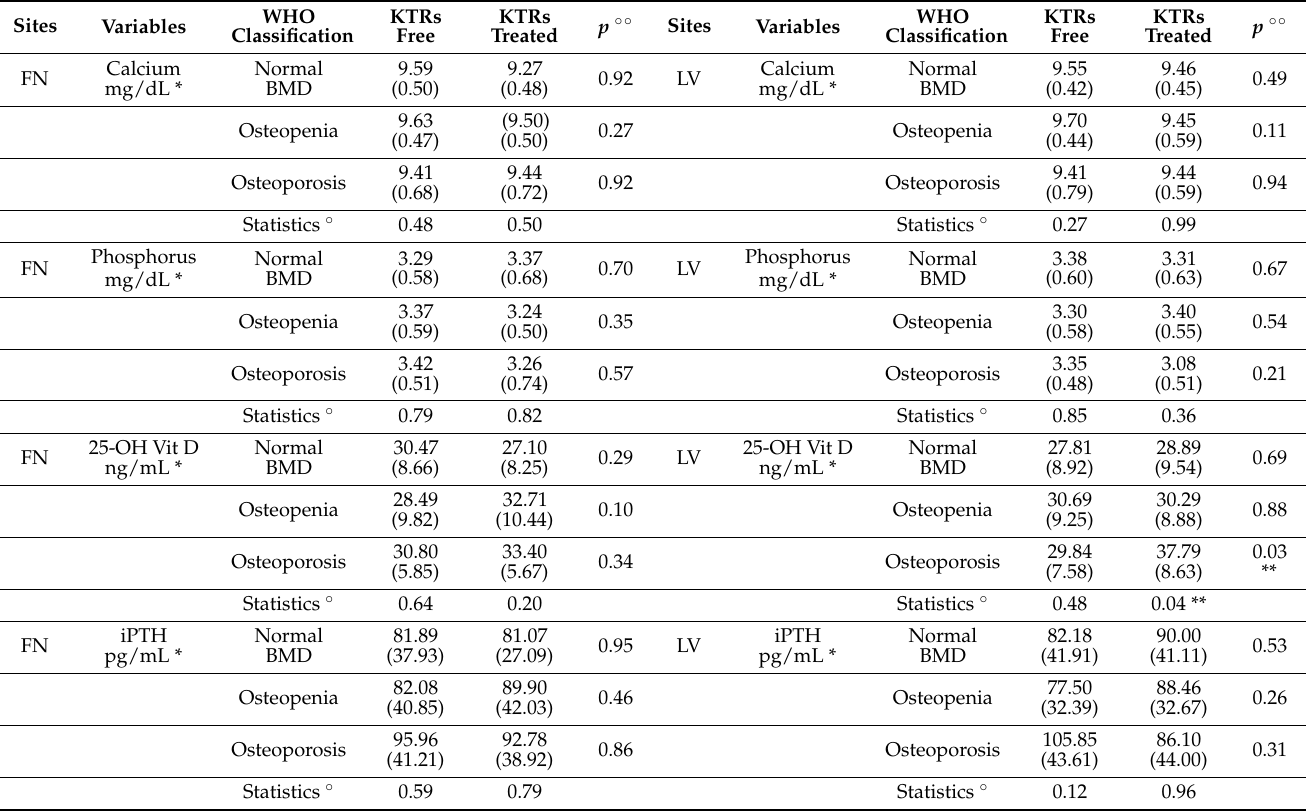
Table 3. Biochemical data at the time of the second assessment for both groups.